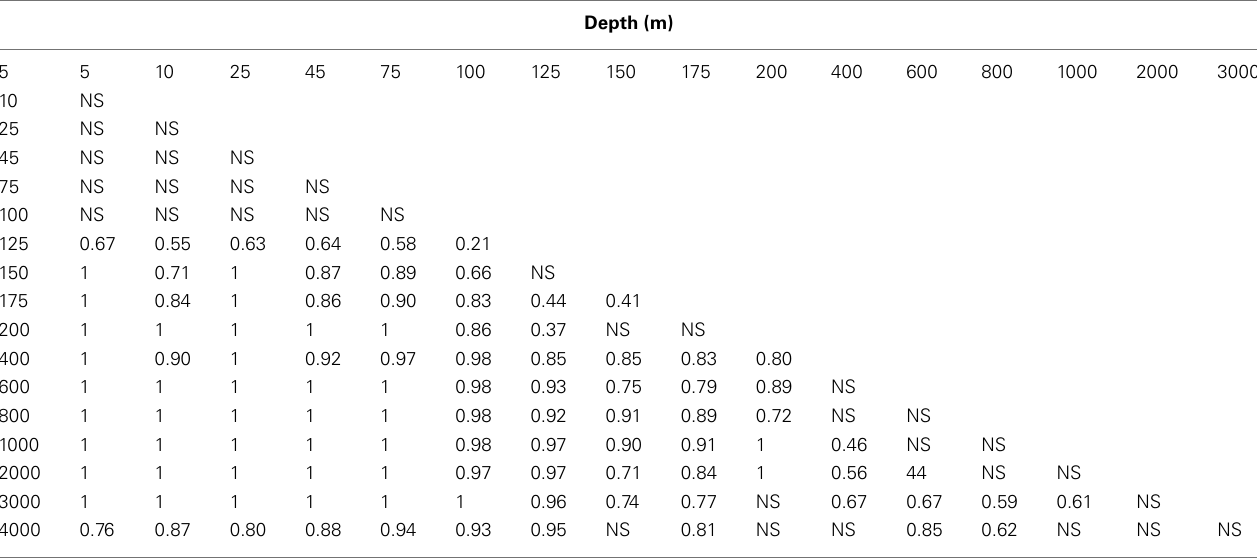
TableA1 | Pair-wise comparison of terminal restriction length polymorphism (T-RFLP) patterns from samples ranging from 5 to 4000m depth usingANOSIM based on Bray–Curtis